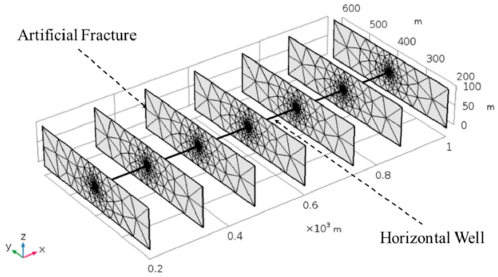
Figure 6. A numerical model of a multi-section fractured horizontal well.